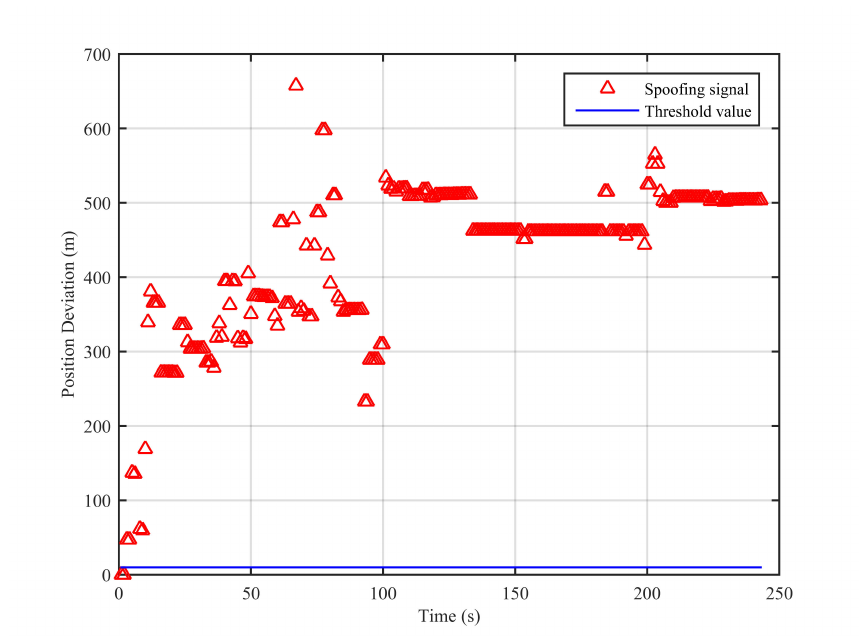
Figure 11. Position deviations of the two algorithms (dynamic whole-time duration position spoofing scenario).